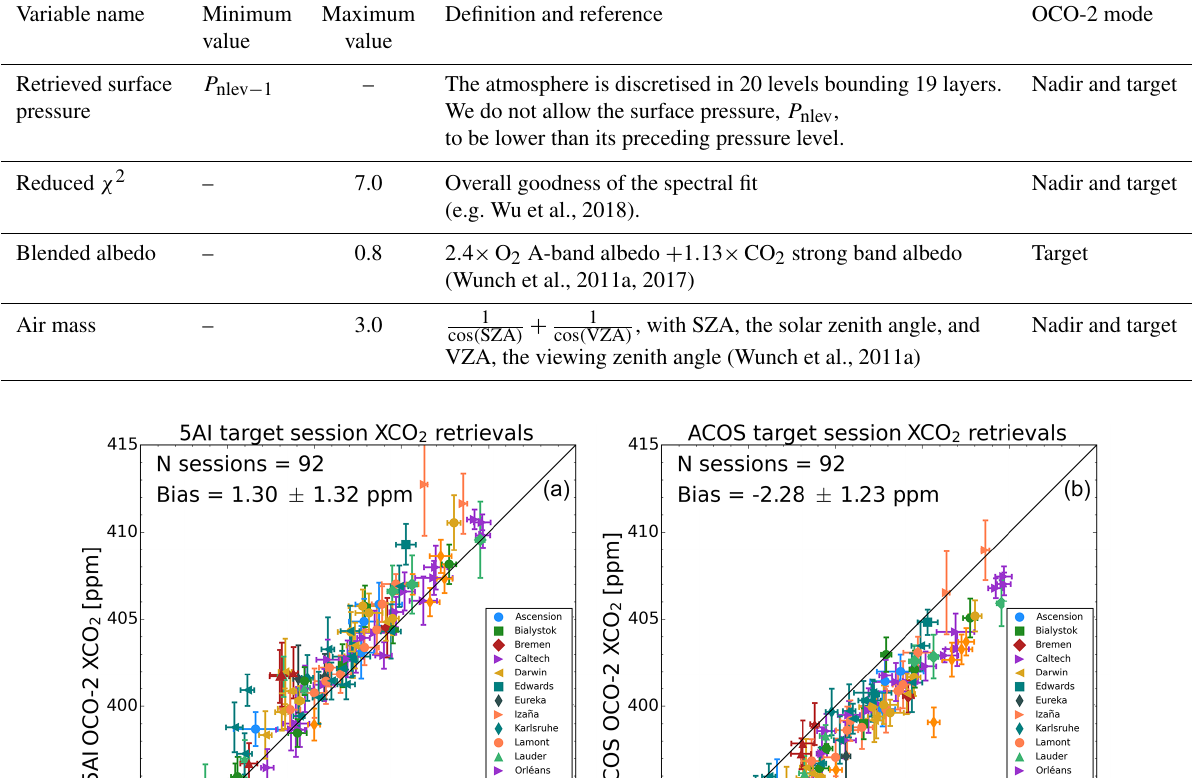
product. Individual 2 , and error bars show 2